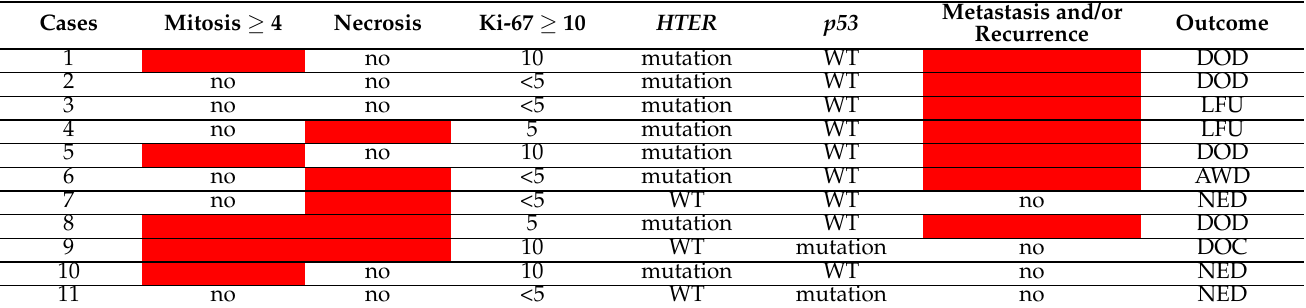
Table 8. Intermediate-risk solitary fibrous tumor (N =